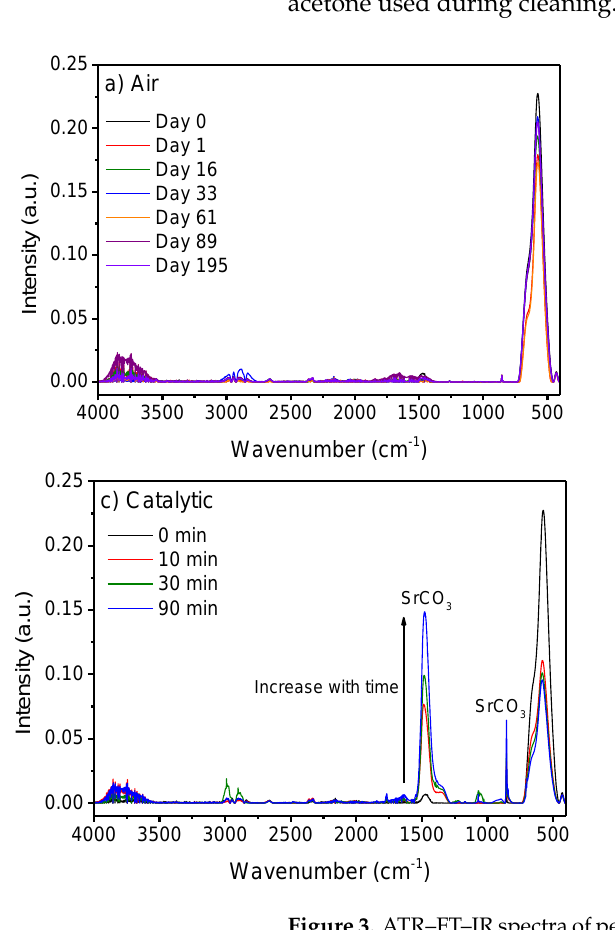
Figure 3. ATR – FT – IR spectra of perovskites stored for various durations ( a ) in air at room temper- ature, ( b ) dispersed in water at 60 °C, and ( c ) used as catalysts for degradation of bisphenol A at 60 ( b ) dispersed in water at 60 ◦ C, and ( c ) used as catalysts for degradation of bisphenol A at 60 ◦ C. °C. SrCO 3 signals are marked. SrCO 3 signals are